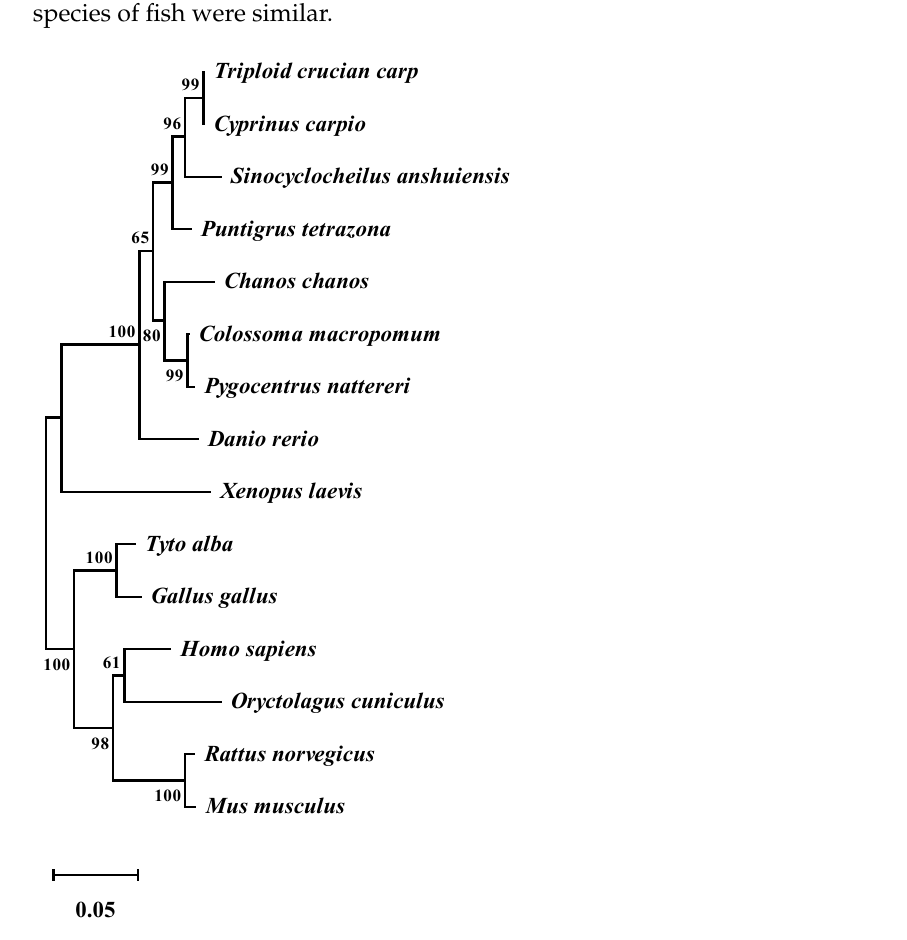
Figure 1. Phylogenetic tree of LKB1 constructed using the Neighbor-Joining method. The accession numbers are as below: triploid crucian carp OL961664, Cyprinus carpio XP_042575073.1, Puntigrus